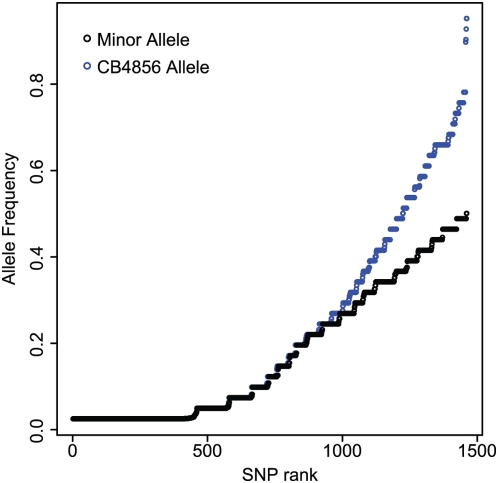
The Hawaiian isolate CB4856 has a large excess of rare alleles.Each of 1460 SNPs is plotted according to the frequency of the minor allele (black) or the frequency of the CB4856 allele (blue). Under panmixis, our SNP ascertainment should cause both sets of points to fall on straight lines, connecting allele frequencies 1/41 and 20/41 for minor allele frequency and 1/41 and 40/41 for Hawaii allele frequency. The plot shows that there is a large excess of rare alleles and that these rare alleles are CB4856 alleles.